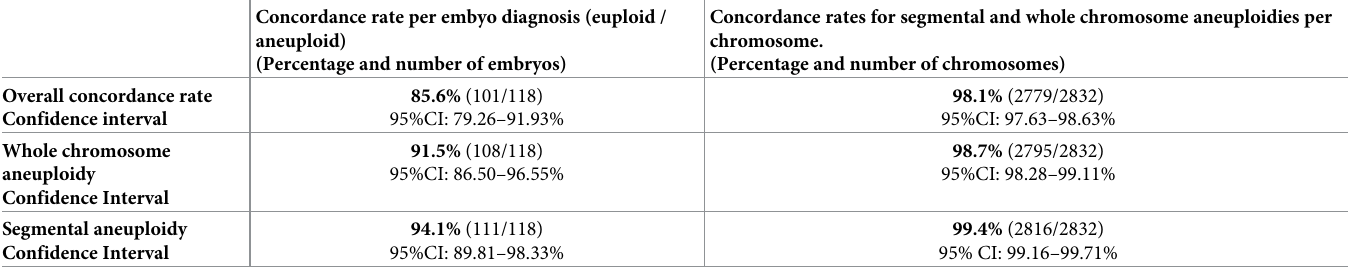
Table 3. Concordance rates per embryo diagnosis (euploid / aneuploid) and for segmental and whole chromosome aneuploidies per chromosome. Concordance rate per embyo diagnosis (euploid / aneuploid) (Percentage and number of embryos)